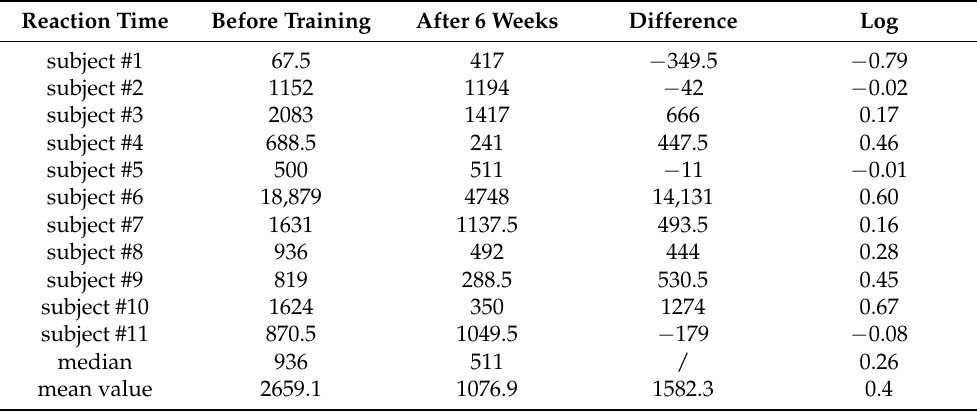
Table 2. Development of the reaction time in msec of the individual threshold before training and after six weeks of training, listing the difference in msec as well as the logarithmic.